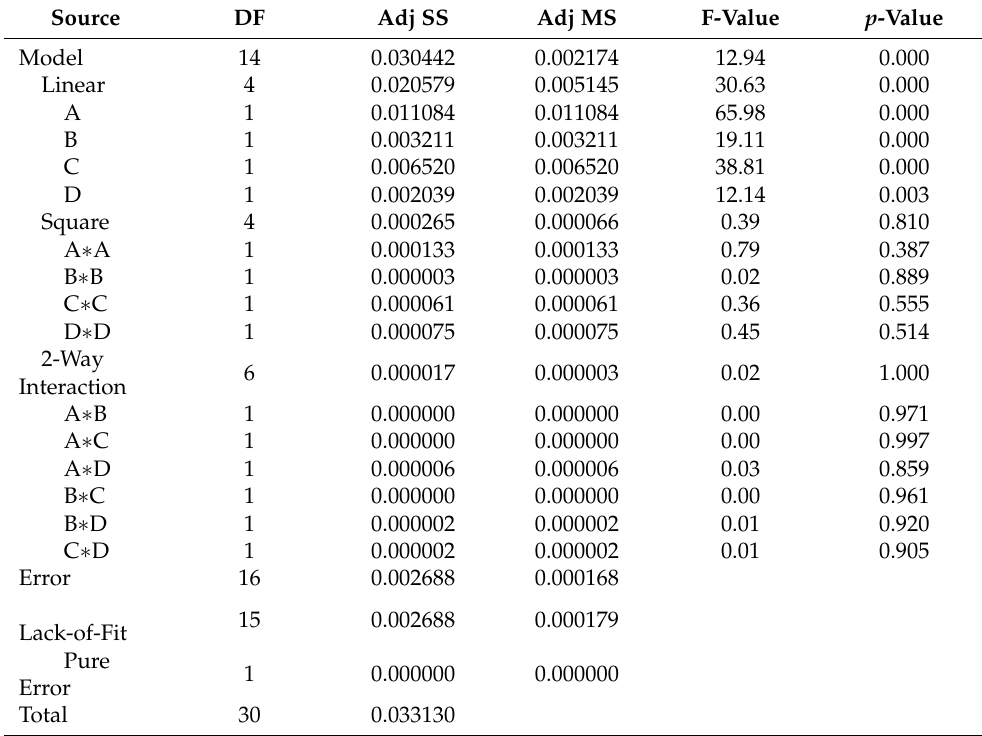
Table 3. Analysis of variance for biovanillin production produced by Punica granatum